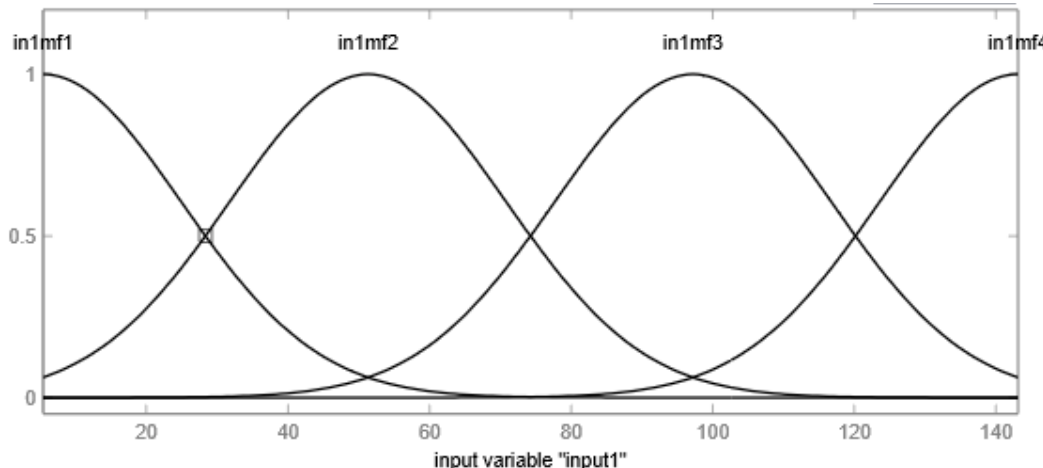
Figure 10. Membership function for input variable 1 i.e., Haematuria.